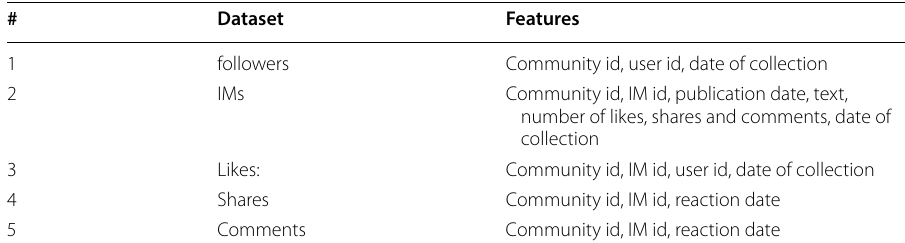
Table 1 Forecast quality assessment’ methods